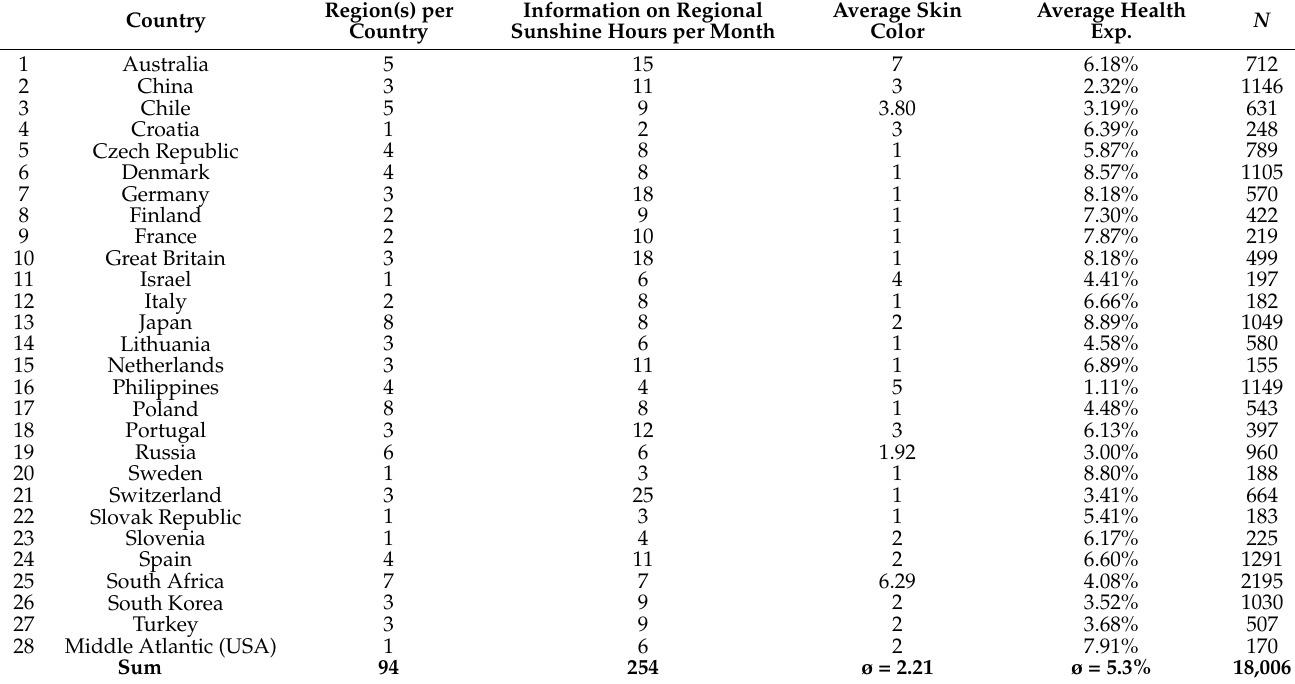
Table 2. Data points per country and country